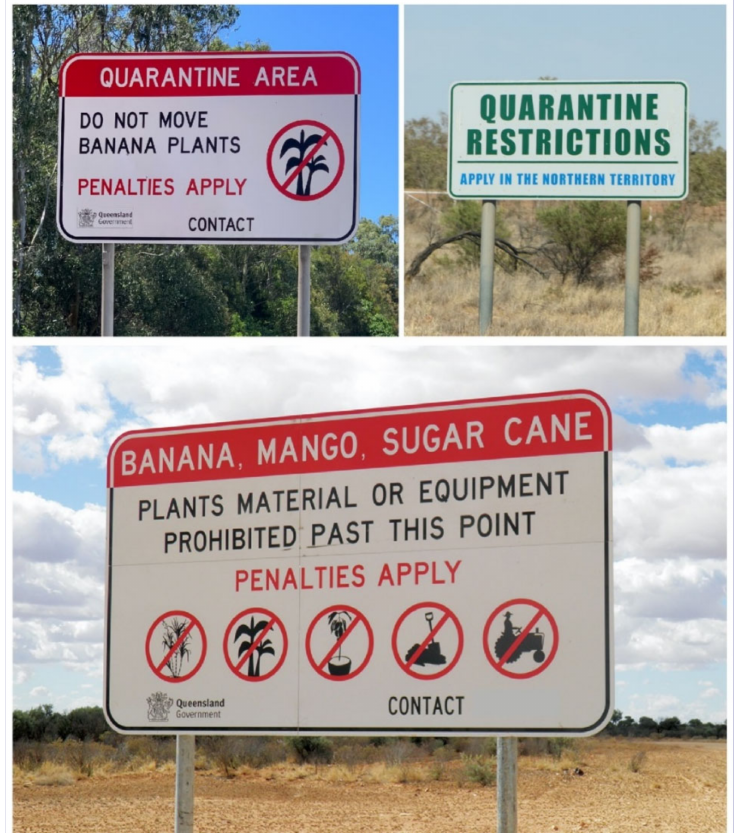
Figure 1. Containment measures as a strategy to mitigate the spread of plant viral diseases. Some countries such as Australia have strong policies to halt the spread of plant diseases, including viral ones, based on confinement and limitation on the movement of plant material and equipment. Image credit (bottom picture): Biosecurity